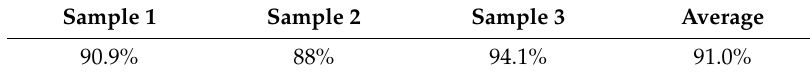
Table A4. The cell viabilities (in percentage) obtained.